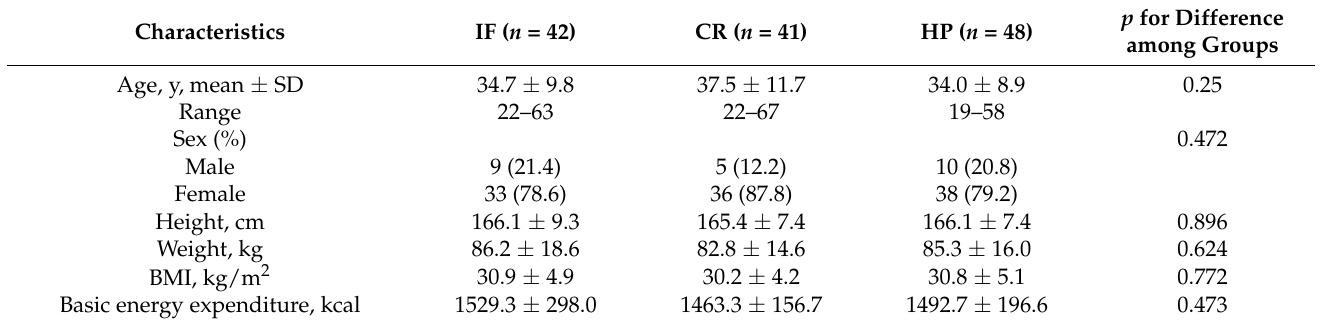
Table 2. Participant characteristics after 12 weeks of weight loss